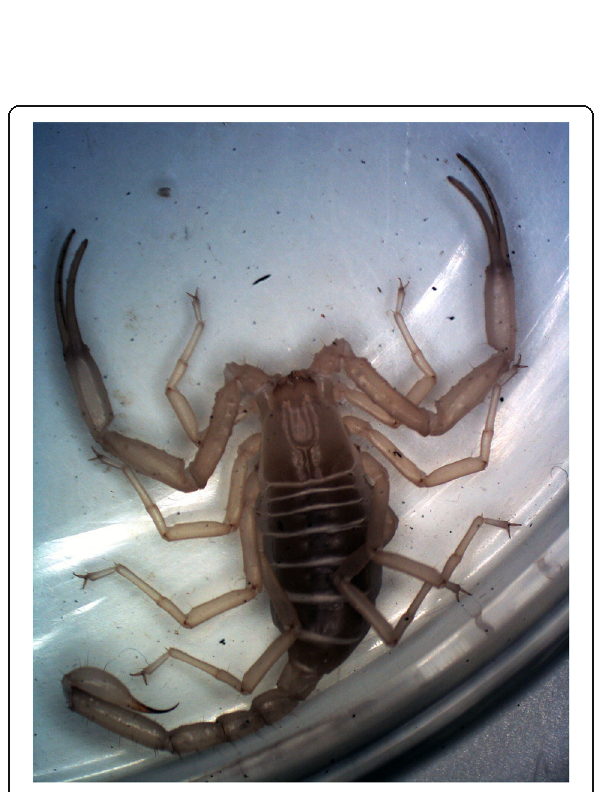
Fig. 2 Vietbocap thienduongensis Lourenço & Pham (Pseudochactidae). A cave scorpion from Vietnam, the specimen is an adult male (copyright by D.-S. Pham, reproduced with